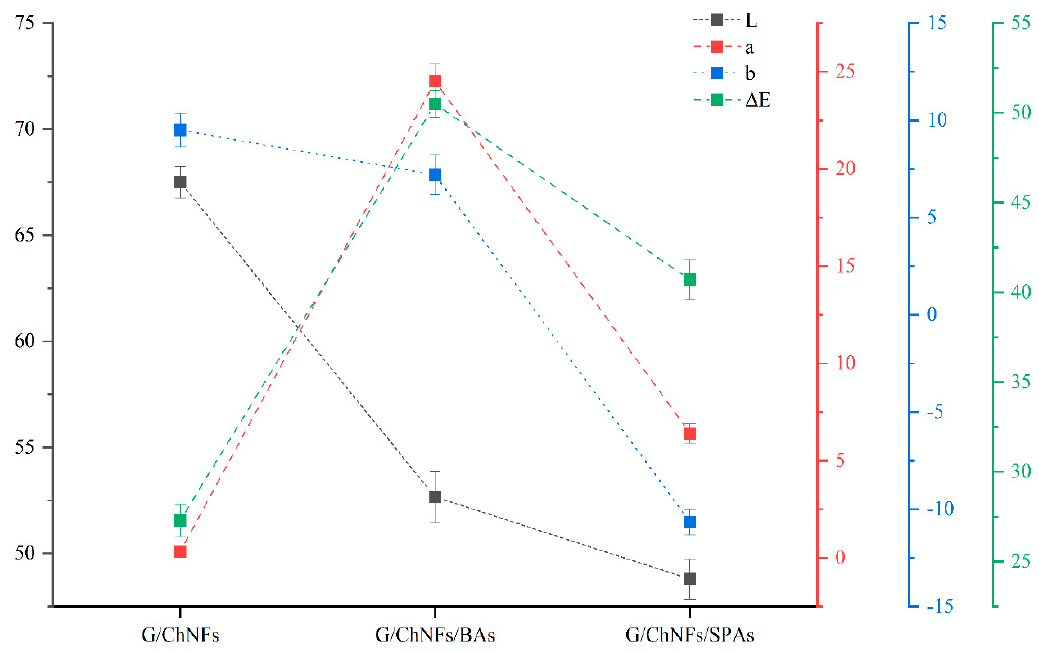
Figure 6. Color coordinates ( L , a , b , and Δ E ) of anthocyanin-loaded halochromic smart